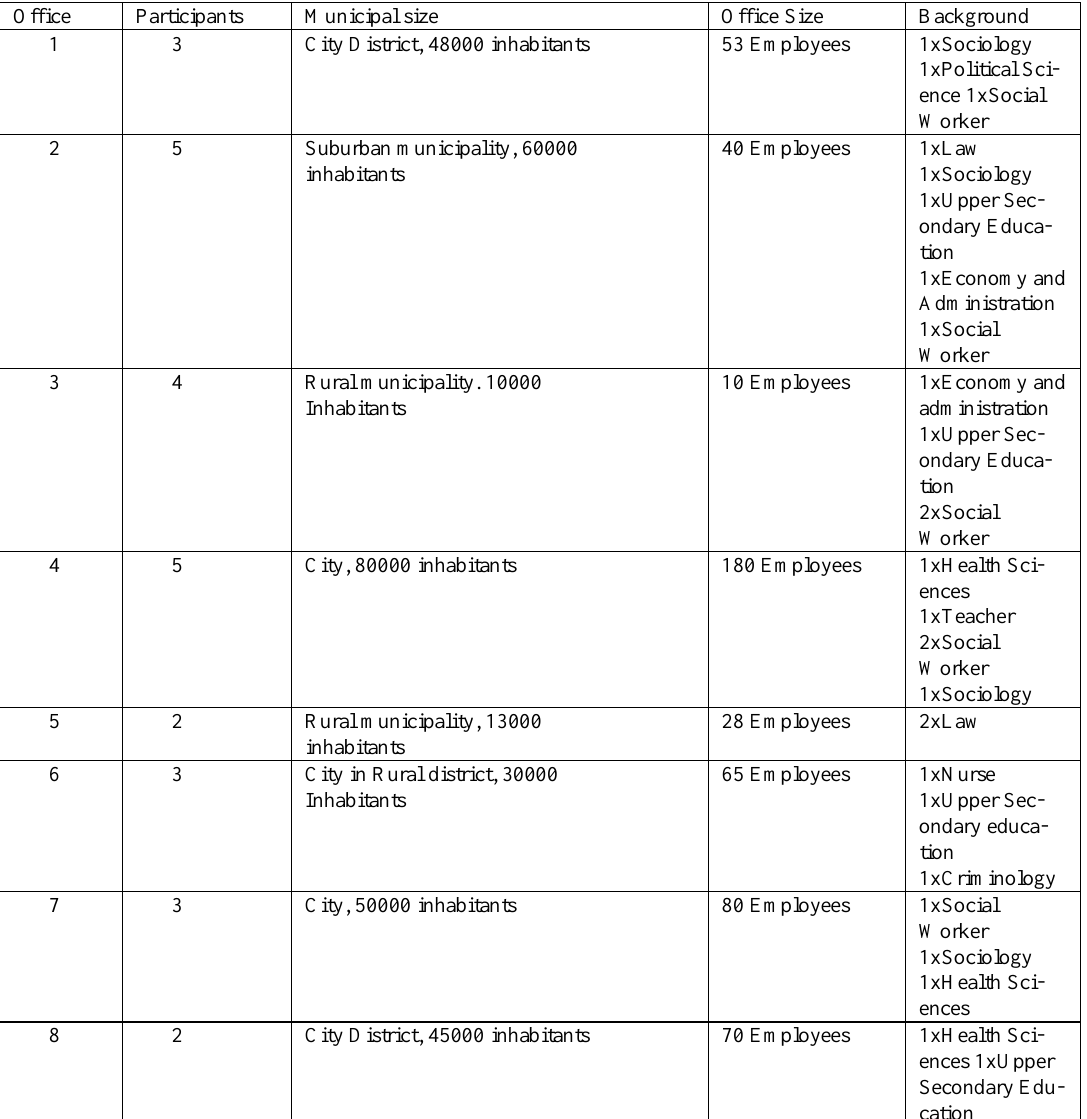
Table 1. Background information on the focus groups and background of partici-